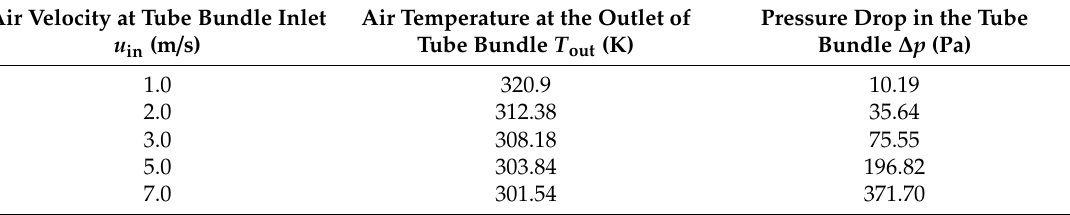
Table 5. Output data for the perforation hole Ø3